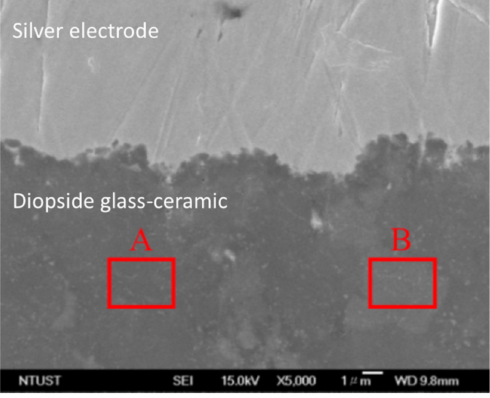
Figure 7. SEM micrograph and EDS data showing compositions corresponding to regions A and